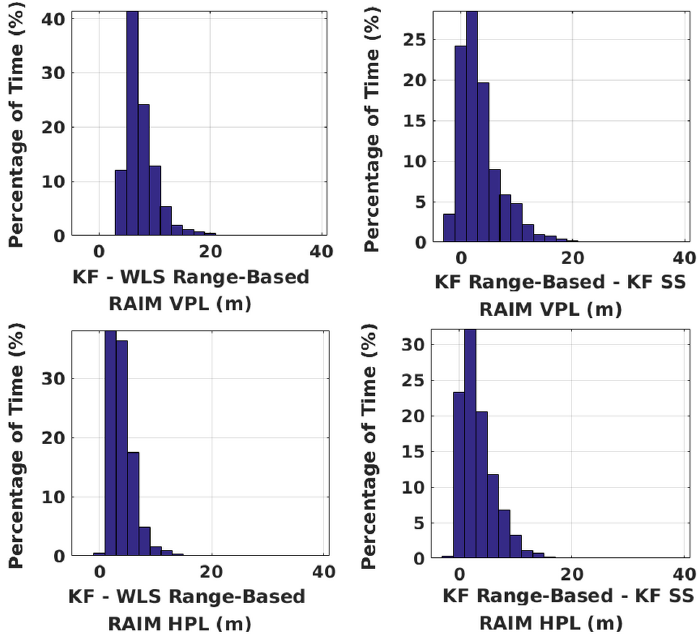
Figure 8. Performance comparison of all integrity algorithms over all simulations with GPS and NavIC. SS stands for solution separation. Along the x-axis, the difference between the center points of any two adjacent bins is 2